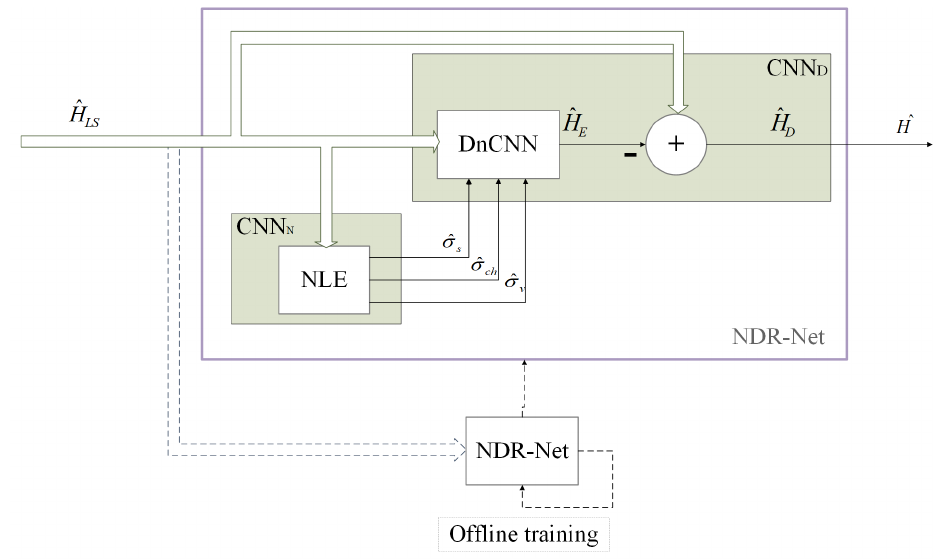
Figure 3. The framework of NDR-Net.